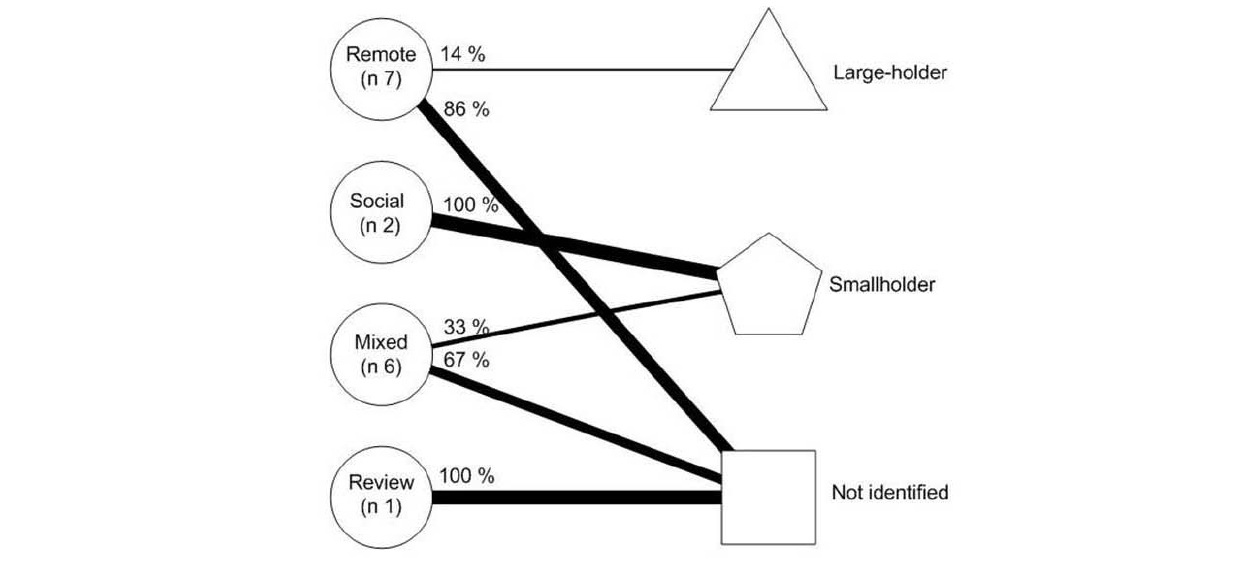
Fig. 4. Actor focus of the different research approaches, using studies from Brazil. The thickness of the lines linking the shapes represent the percentage of studies focusing on each actor